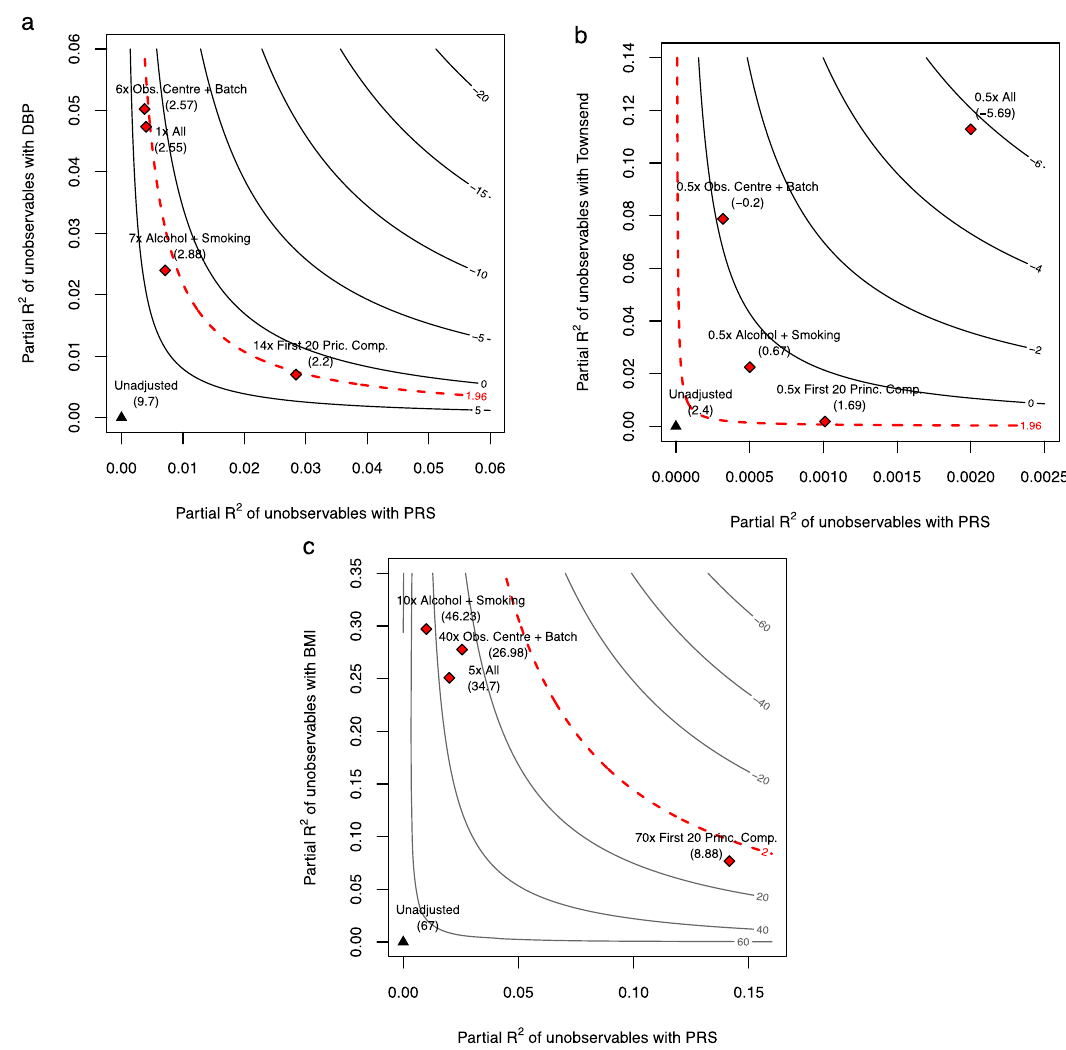
Fig. 3 Sensitivity contours for the null hypothesis of zero effect of each genetic association. a Diastolic Blood Pressure (DBP). b Townsend deprivation index (deprivation). c Body Mass Index (BMI). The caption of Fig. 2 provides details on how to interpret the contour